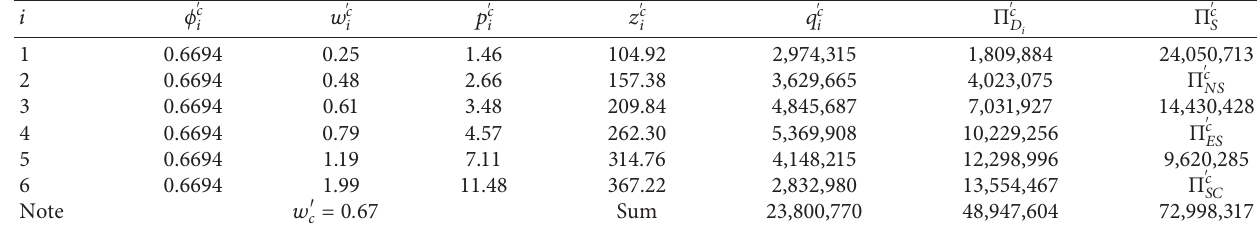
Table 9: Numerical analysis results of coordination decision scenario without WGD